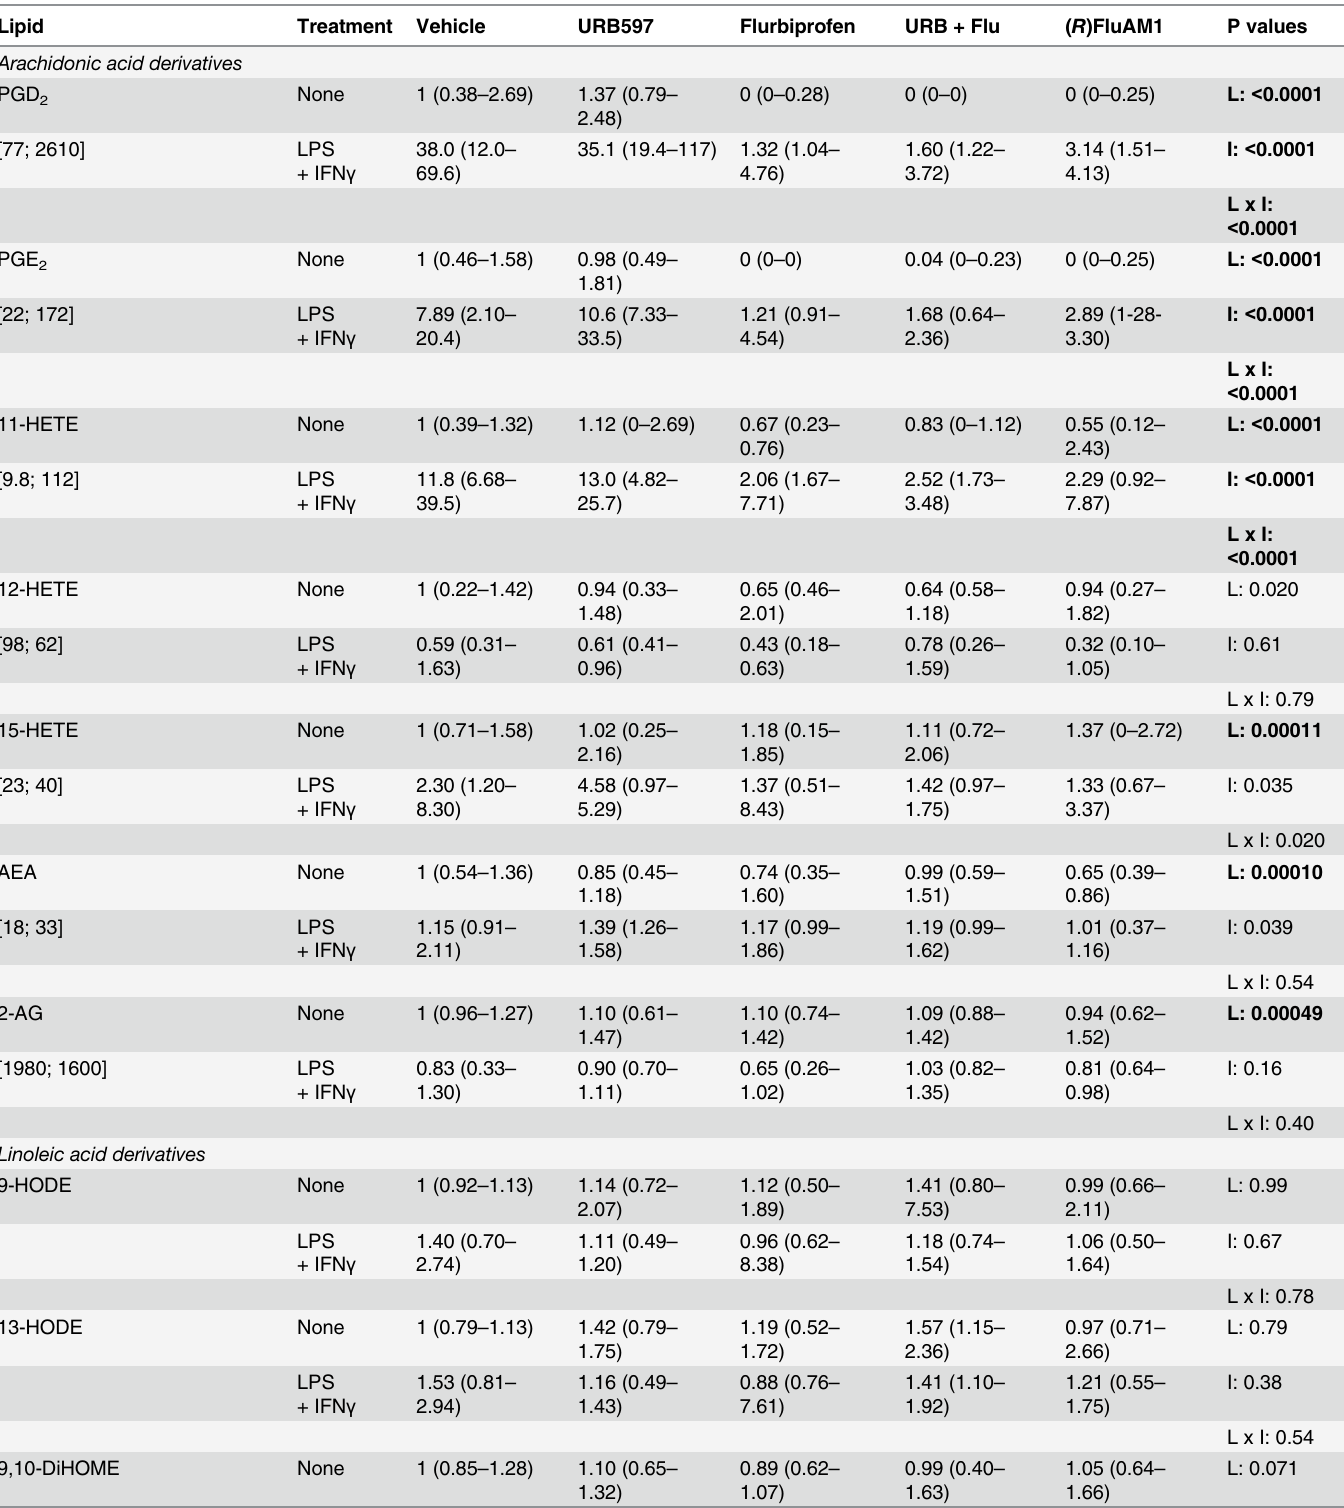
Table 1. Lipid profile of RAW264.7 cells treated with or without LPS + IFN γ for 24 h. Effects of FAAH and/or COX inhibitors. Lipid Treatment